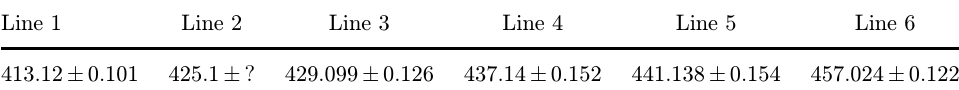
Table 2. Lines with averaged values in Da in MALDI spectra of urine fractions.